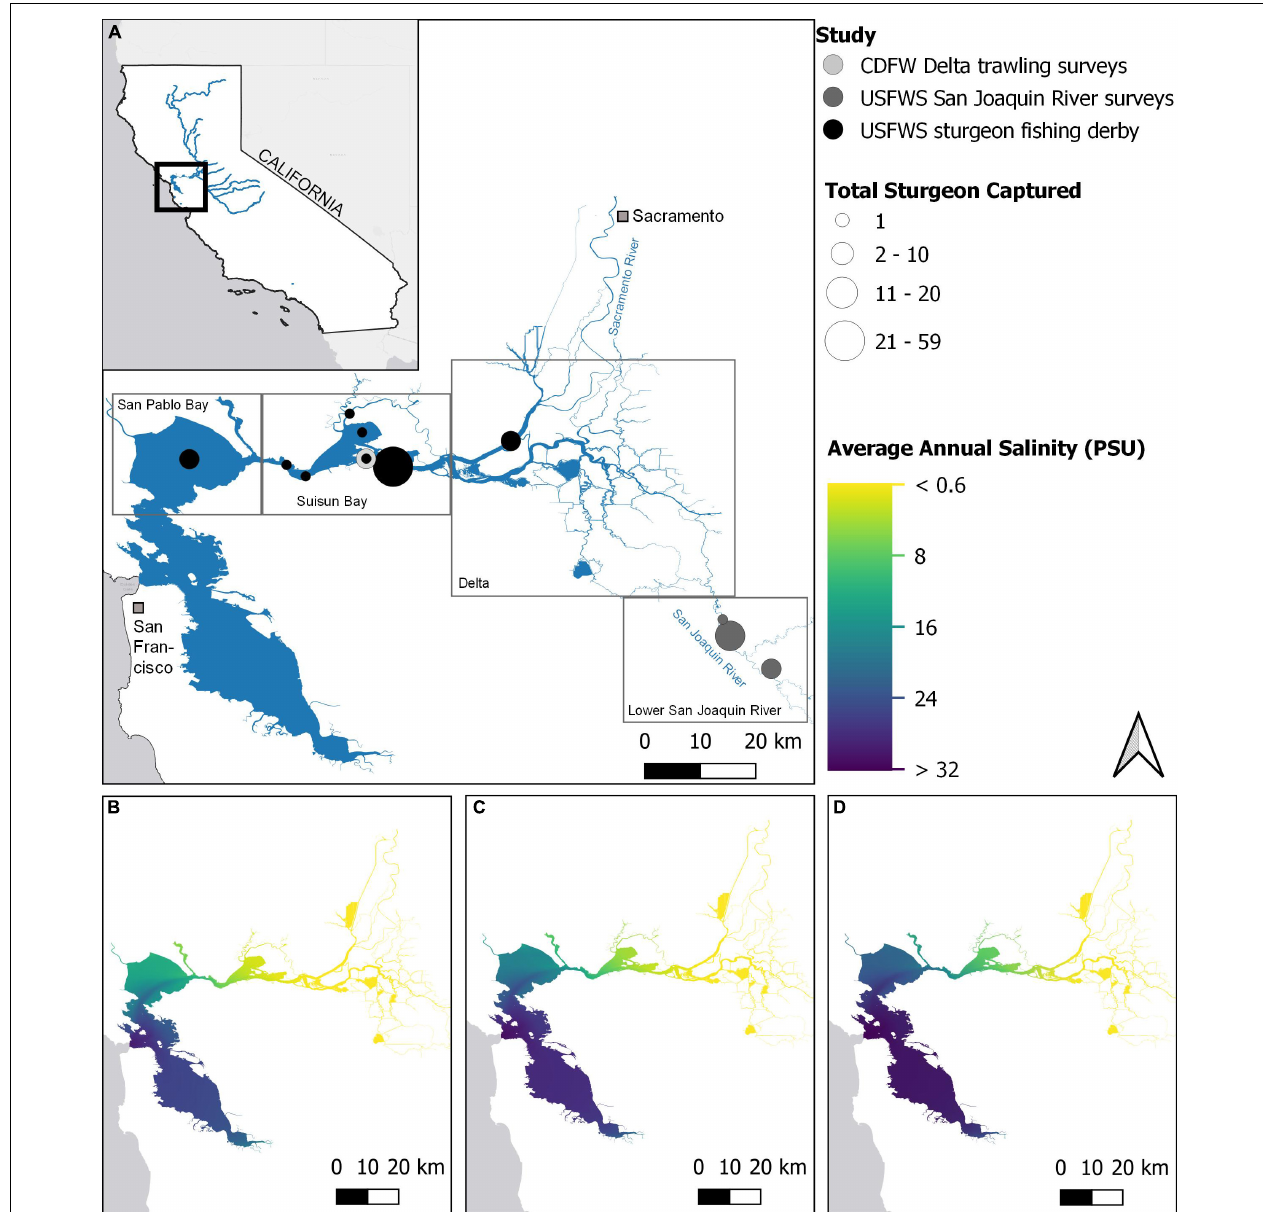
FIGURE 1 | (A) Overview of the four subregions of the San Francisco Estuary (SFE) and fin ray collection sites used in this study. The three lower panels display annual average salinity conditions in the SFE during (B) flood (2011), (C) average (2010), and (D) drought years (2008). Data adapted from MacWilliams et al. (2016). Legend acronyms are California Department of Fish and Wildlife (CDFW) and U.S. Fish and Wildlife Service